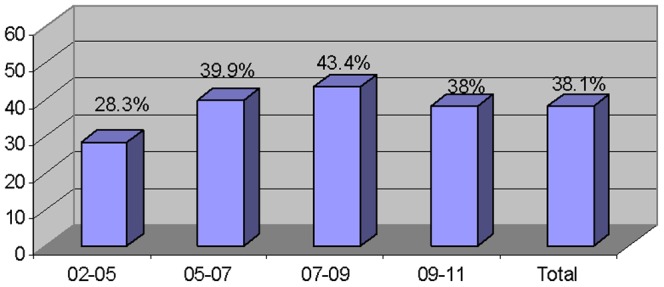
HPV incidence in males per years of study.